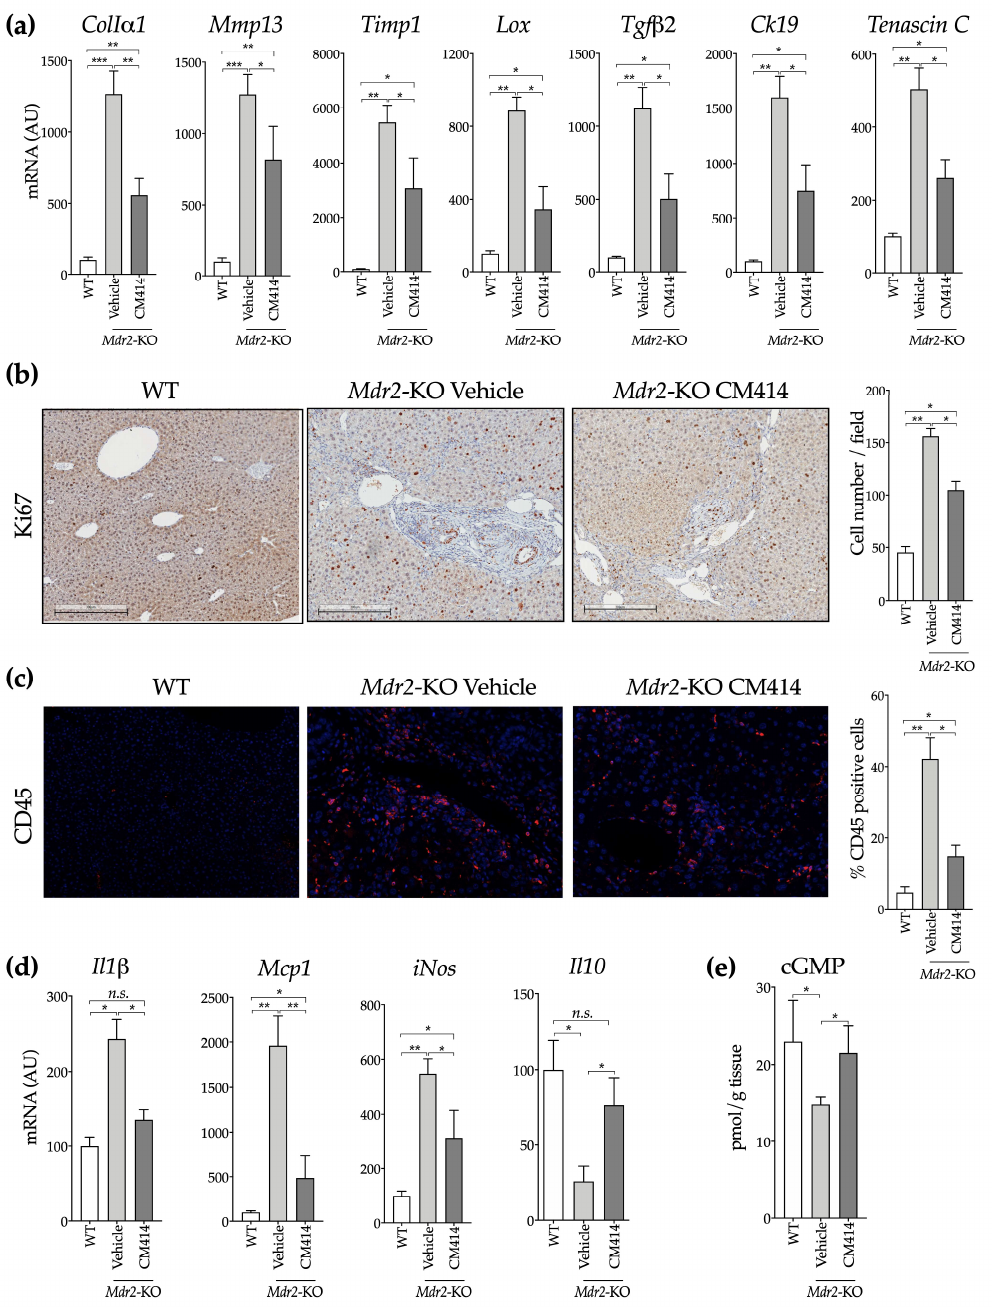
Figure 4. Evaluation of inflammation, fibrosis, and cell proliferation-related markers in the liver of WT, vehicle-treated Mdr2 -KO, and CM414-treated Mdr2 -KO mice. ( a ) qPCR analyses of the hepatic expression of fibrogenic activation-related genes. ( b ) representative immunohistochemical staining of Ki67 in liver sections. Graph on the right shows the quantification of Ki67 positive cells. ( c ) representative immunofluorescent staining of CD45 in liver sections. Graph on the right shows the quantification of CD45 positive cells. ( d ) qPCR analyses of the hepatic expression of inflammation-related genes. ( e ) analysis of cyclic guanosine monophosphate (cGMP) levels in mouse liver tissues. * p < 0.05. ** p < 0.01. *** p < 0.001.